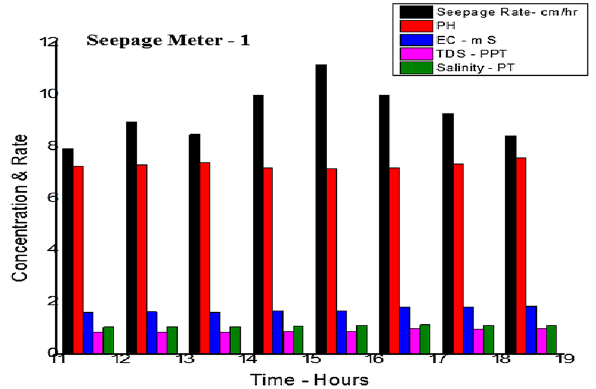
Fig. 5 Comparison of seepage rate and physicochemical parameters for the seepage meter 1